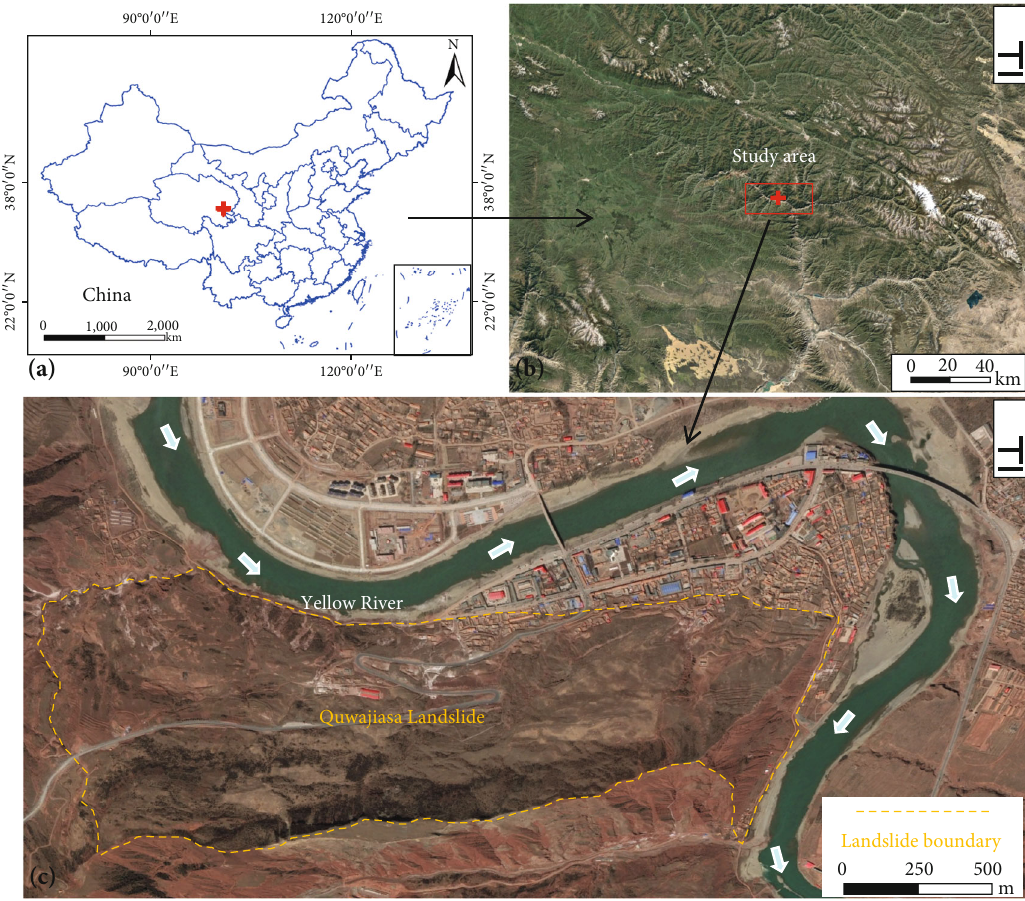
Figure 1: Location and topography of the study